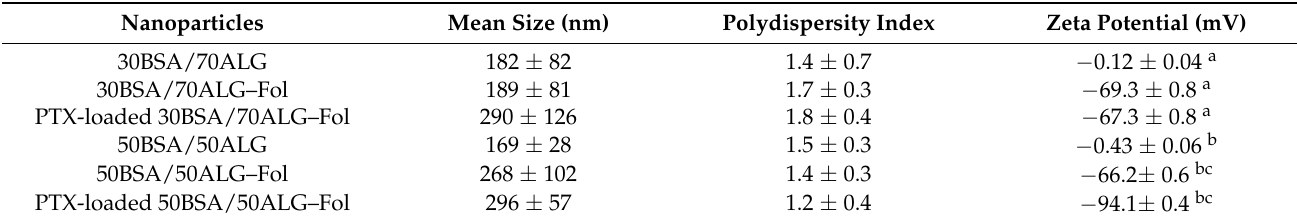
Table 2. Mean size, polydispersity index and zeta potential of nanoparticles and folate-conjugate nanoparticles determined by quasi-elastic light scattering. Data were shown as mean ±